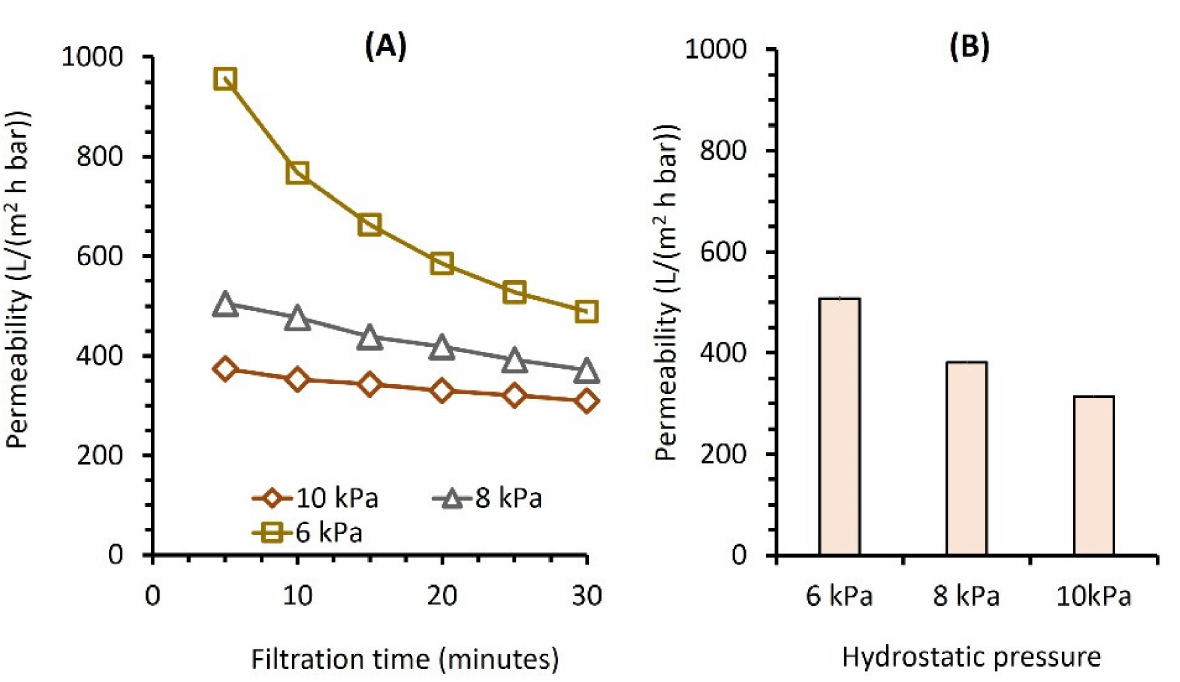
Figure 4. Filtration of laundry wastewater as a function of applied pressure shown ( A ) over time and ( B ) the final